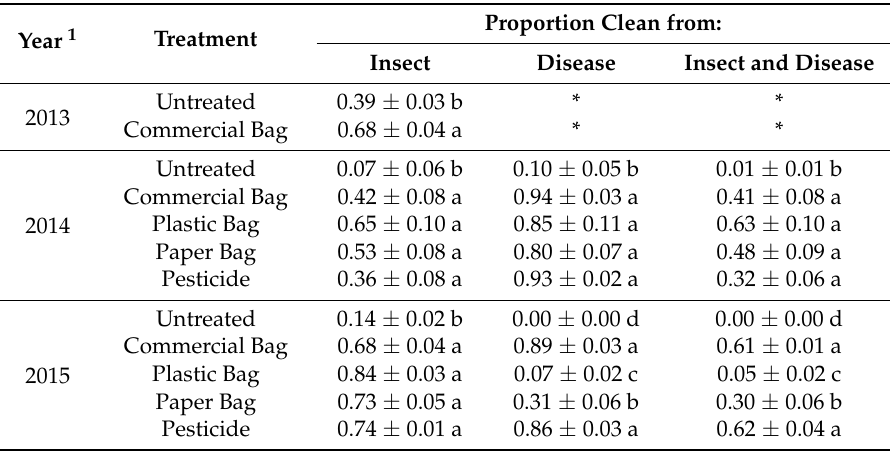
Table 3. Mean ( ± SE) proportion of fruit classified as free of